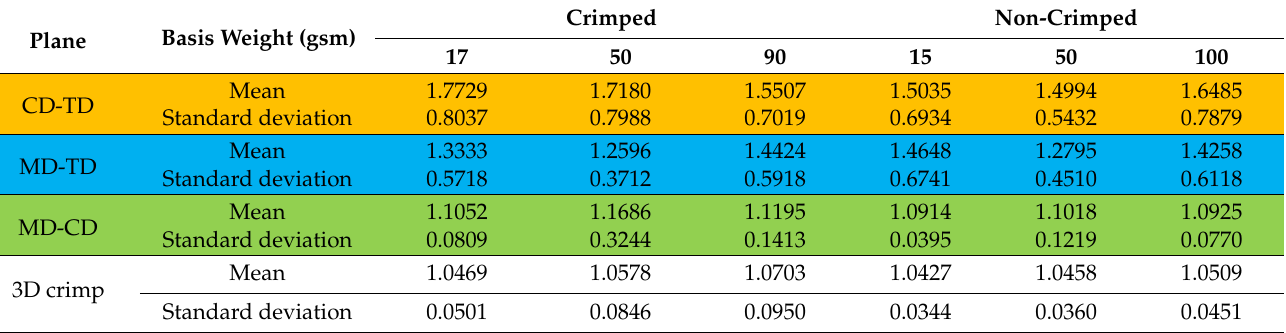
Table A1. Statistical data for crimp in X-ray µ CT models of